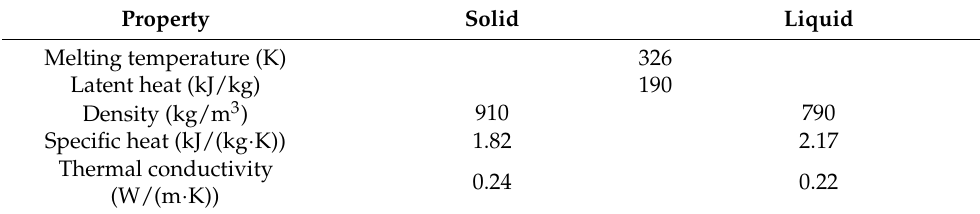
Table 2. Physical property of paraffin wax